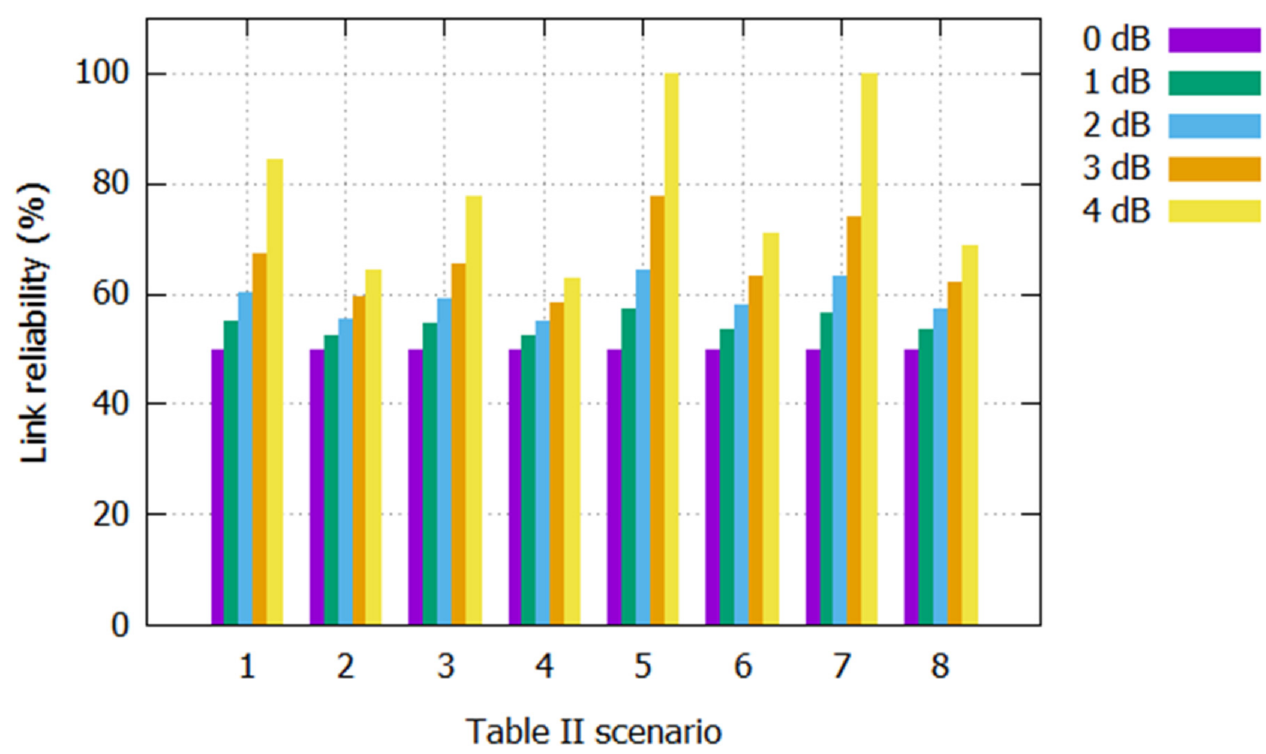
Figure 4. Link Reliability (%) for the different Table 2 scenarios, considering BER for SNR values between 0 and 4 dB, SOVA decoding algorithm and GEMV channel.